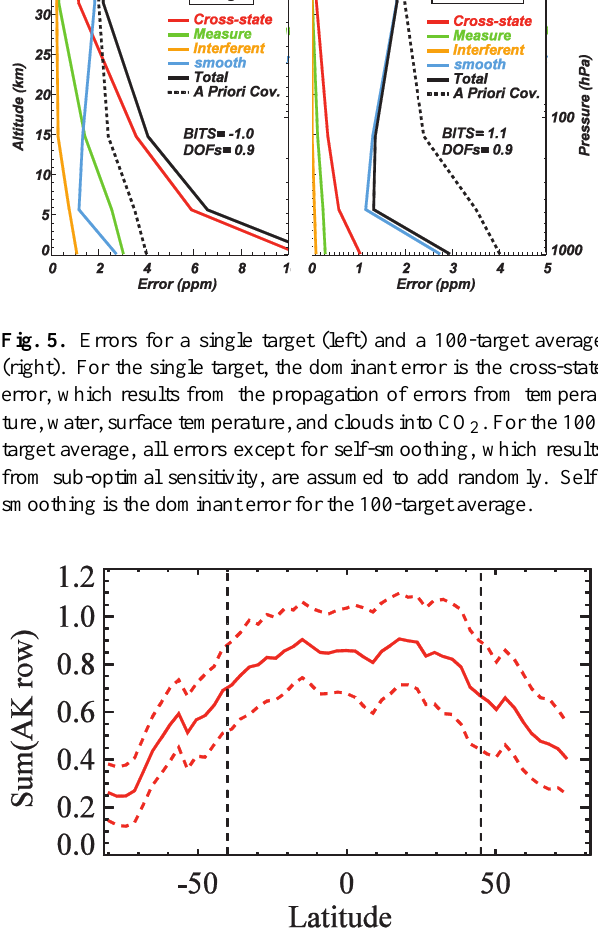
Figure 6 Fig. 6. Sensitivity vs. latitude of the TES CO 2 retrievals in Octo- ber 2006. Since the sensitivity drops off with latitude, only targets between 40 ◦ S to 45 ◦ N are processed to retrieve CO 2